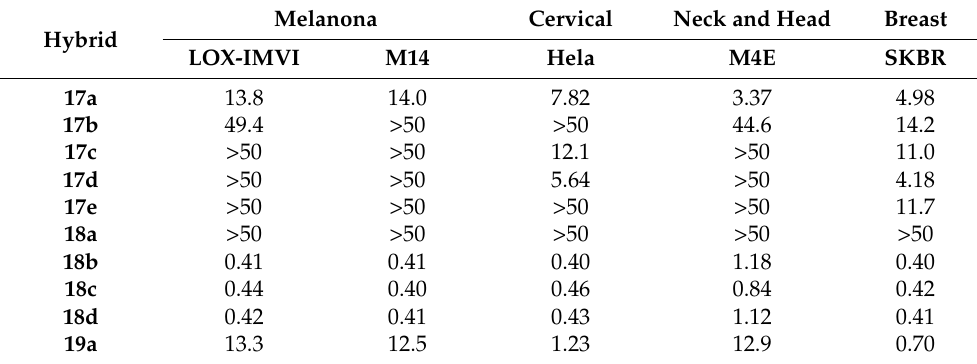
Table 4. The in vitro anticancer activities of the hybrid nitrates 17 – 19a in melanoma, cervical, neck and head, and breast cancer cell lines (IC 50 in µ M)